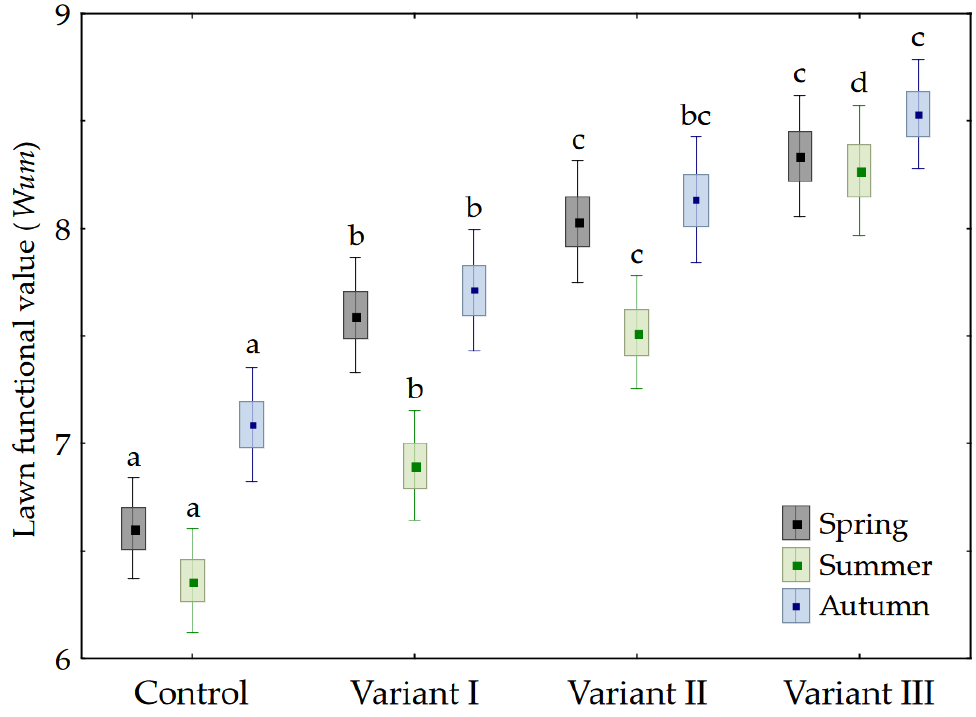
Figure 2. Wum depending on season and fertilizer variant; the same markings (a–d) mean no statis- tically significant changes in the season ( p ≥ 0.05).